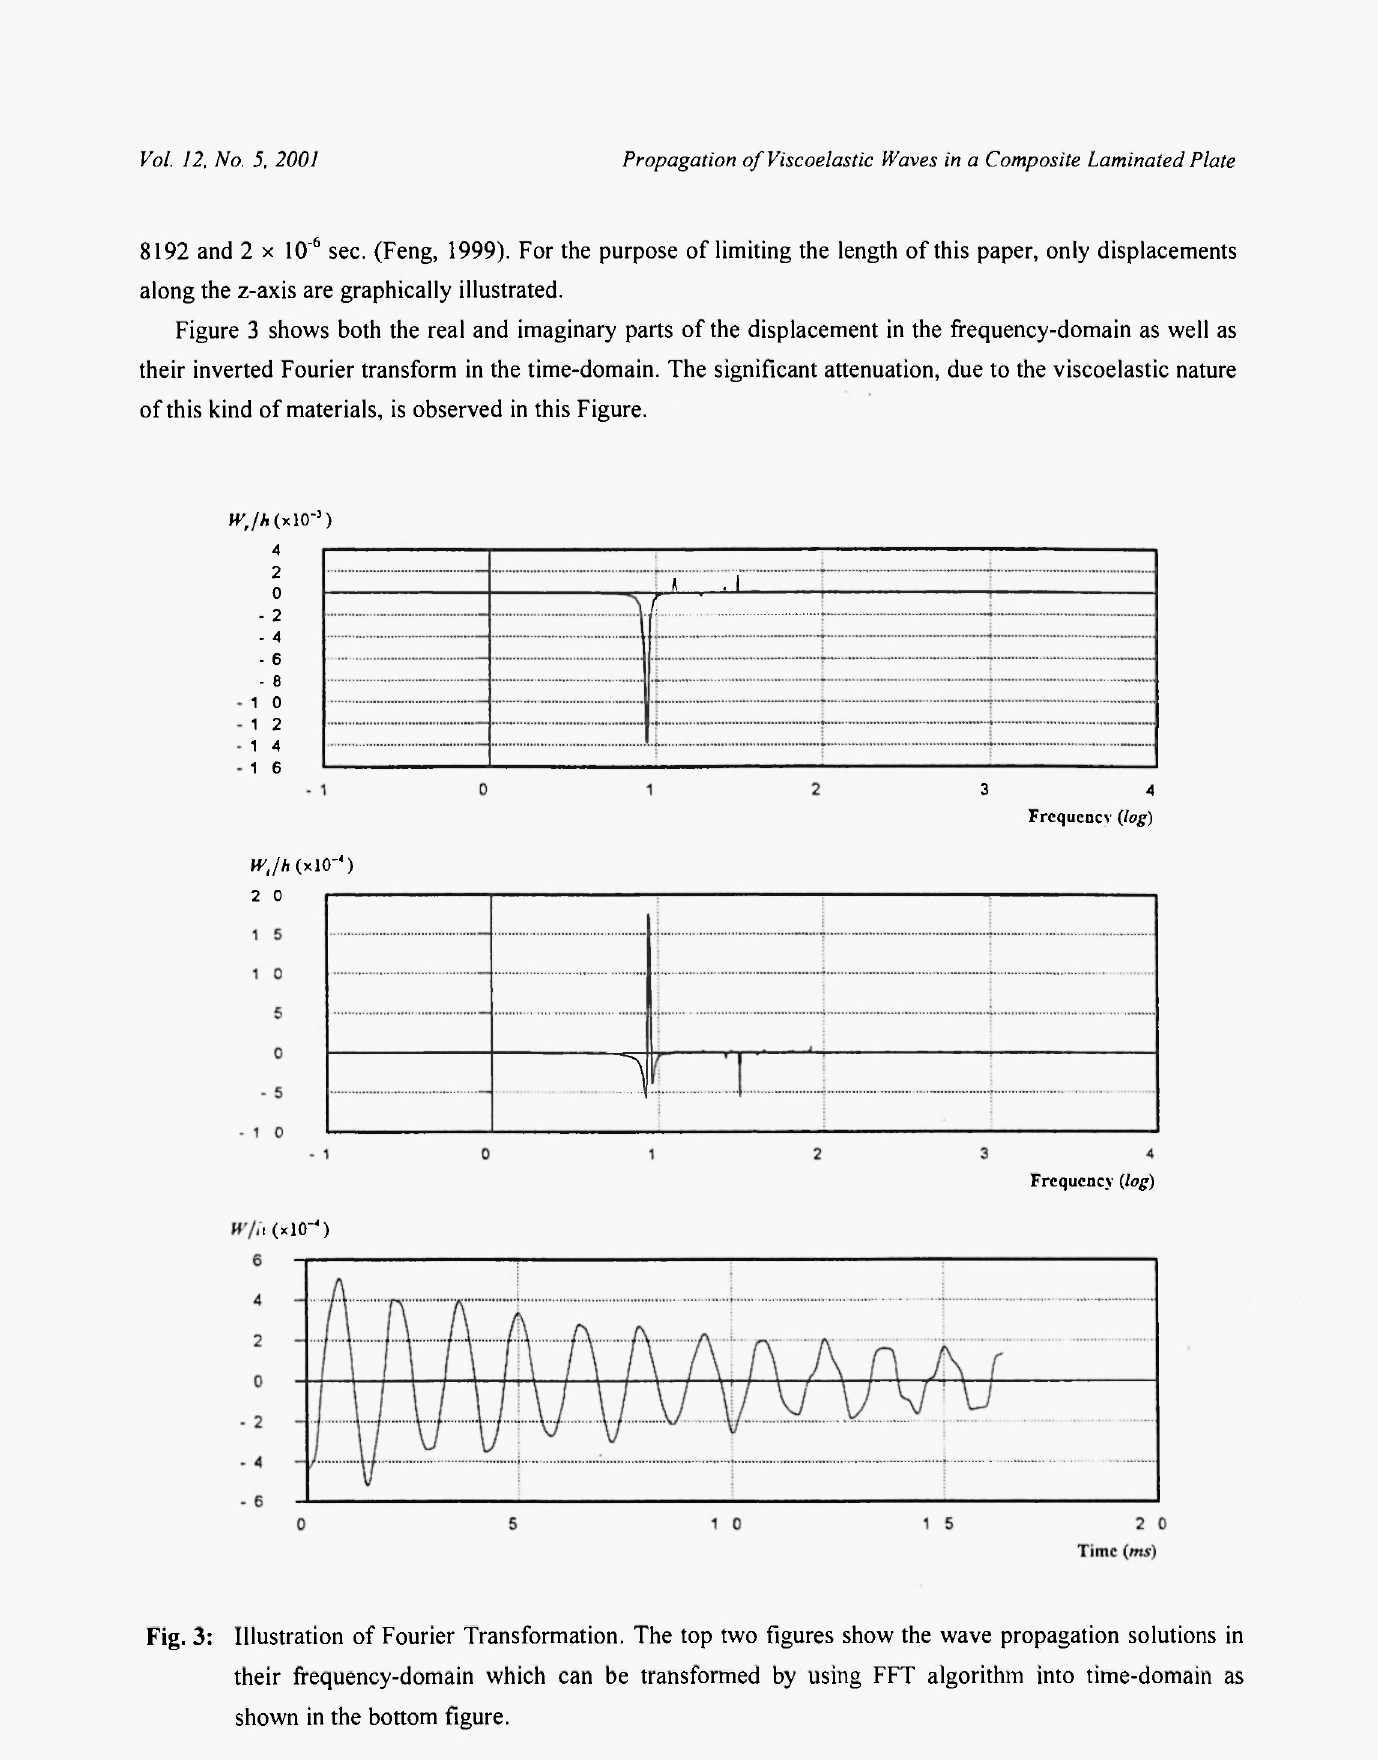
Fig. 3: Illustration of Fourier Transformation. The top two figures show the wave propagation solutions in their frequency-domain which can be transformed by using FFT algorithm into time-domain as shown in the bottom